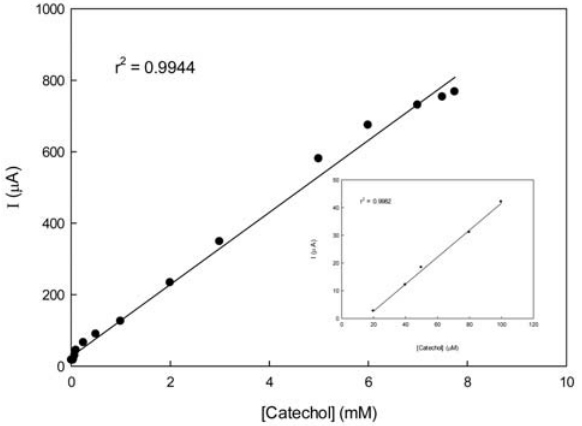
Figure 7. Relationship between response anodic peak current of poly- mer film and catechol concentration in a phosphate buffer solution (pH 5.0) at a scan rate of 50 mV s –1 . Inset shows calibration curve for voltam- metric determination of catechol in concentration range of 10–100 μM.